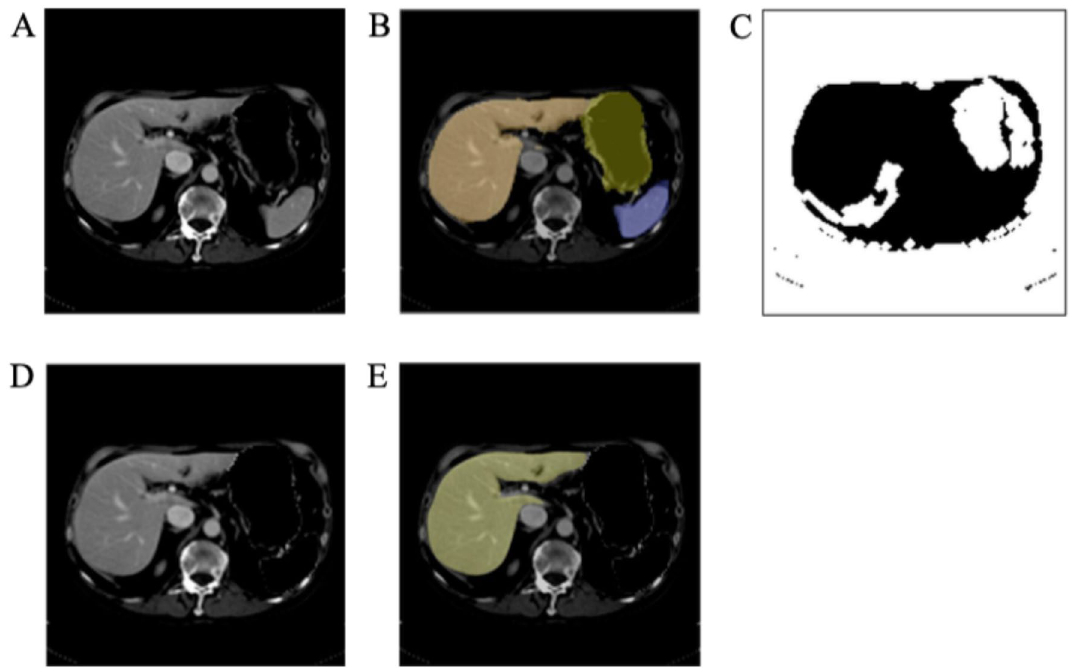
Figure 5. Example outlining intermediate pipeline steps. ( A ) An axial slice of a post-contrast CT image through the middle of the liver. ( B ) Initial result following V-net segmentation. Liver, stomach, and spleen are shaded orange, yellow, and purple, respectively. ( C ) Filter mask for ascites removal. ( D ) Input to the H-DenseUnet. Note that the stomach, spleen, and ascites pixels have been replaced with − 100 HU. ( E ) Final pipeline segmentation result with liver shaded in red. WW and WL are 400 and 50 for all of CT